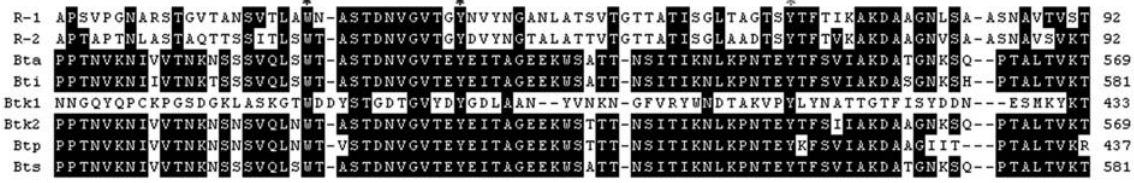
Figure 2 - Alignment of the fibrinectin type III-like domain (FLD). The sequences of the FLD domain of the Bacillus thuringiensis ( Bt ) serovar sotto ( Bt sotto )chitinase(Chi)Schi( Bts )arealignedwiththoseof Bacilluscirculans chitinaseA1(R-1andR-2), Btalesti ChiA74-HD16( Bta ), Btisraelensis Ichi chitinase ( Bti ), Bt kenyae ChiA74 ( Btk 1 and Btk 2) and Bt pakistani ChiA71 ( Btp ). Aromatic amino acid residues typical for FLD regions are indicated by an asterisk.